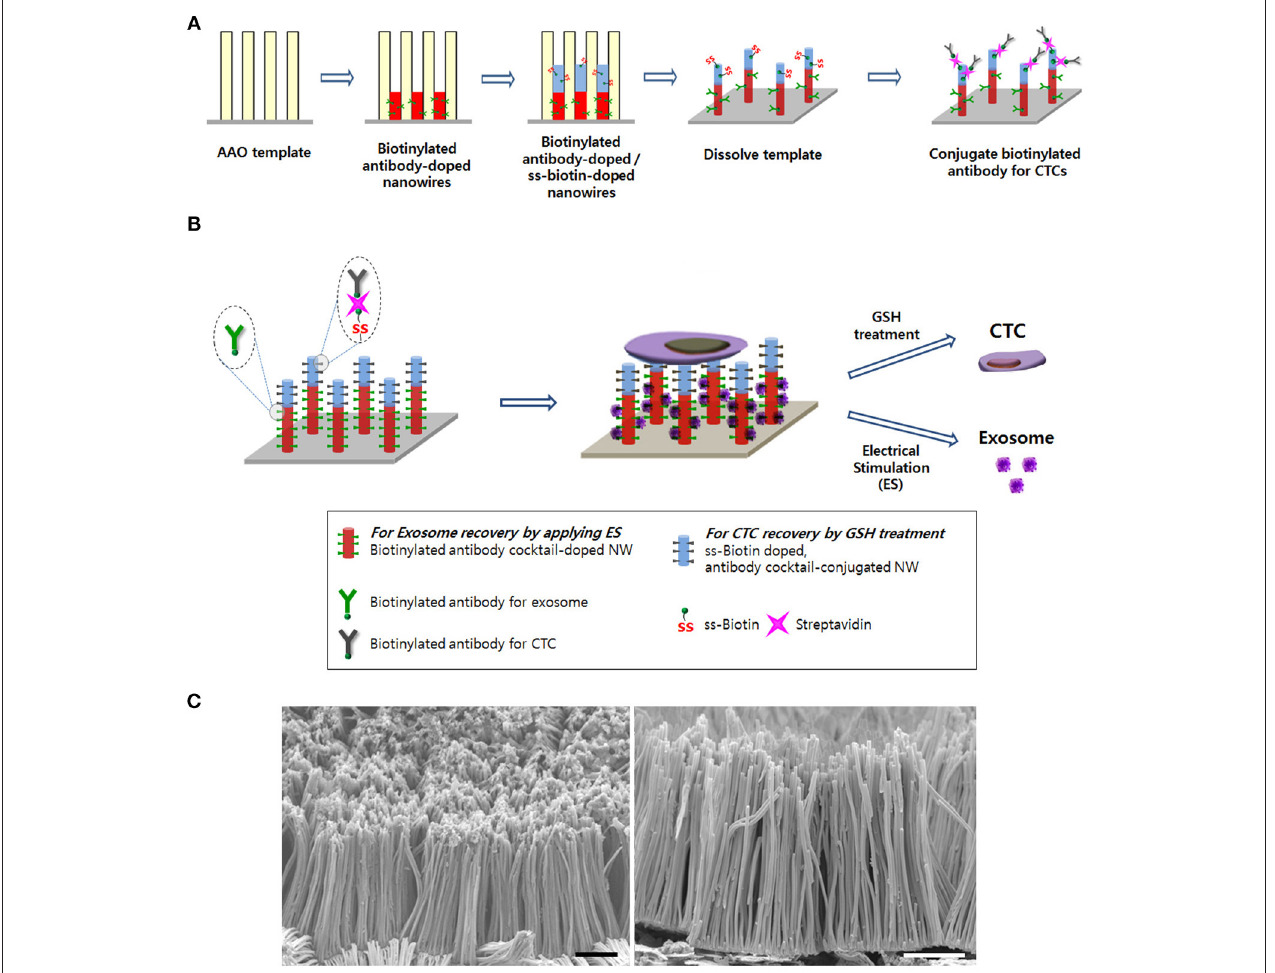
FIGURE 1 | (A) Schematic of the process to synthesize the Ppy nanowire (NW) platform conjugated with simultaneously exosome-specific antibodies and CTC-targeting antibodies. (B) Schematic illustration of exosome and circulating tumor cells (CTCs) recovery from the same NW array (200nm in diameter and 14 µ m in length). This newly introduced platform possesses unique features by means of (i) doping exosome-specific biotinylated antibodies (i.e., anti-CD9, anti-CD81, and anti-CD63) to the bottom of the NW that could greatly enhance exosome isolation via the application of electrical stimulation (ES) and (ii) doping disulfide (SS)-biotin to the top of the NW that is further conjugated with CTC-targeting antibodies (i.e., anti-EpCAM, anti-EGFR, anti-vimentin, anti-N-cadherin, and anti-Trop2), which consequently releases the captured CTCs from the NW platform via GSH treatment. (C) Scanning electron microscopy images of the nanowire platform (scale bars = 5 µ